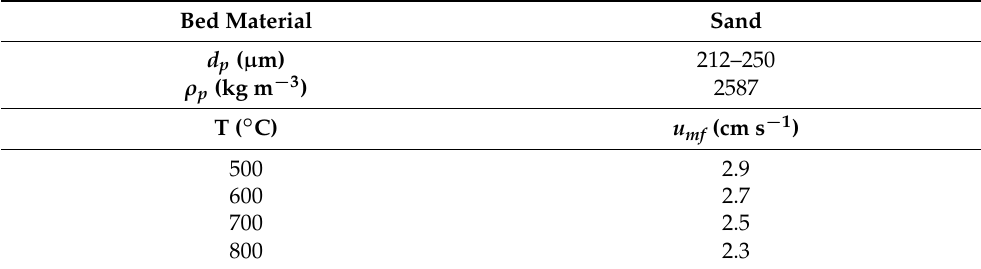
Table 1. Bed material: physical properties of fluid-dynamic interest and minimum fluidization velocity ( u mf ) as a function of temperature at devolatilization conditions described in Section